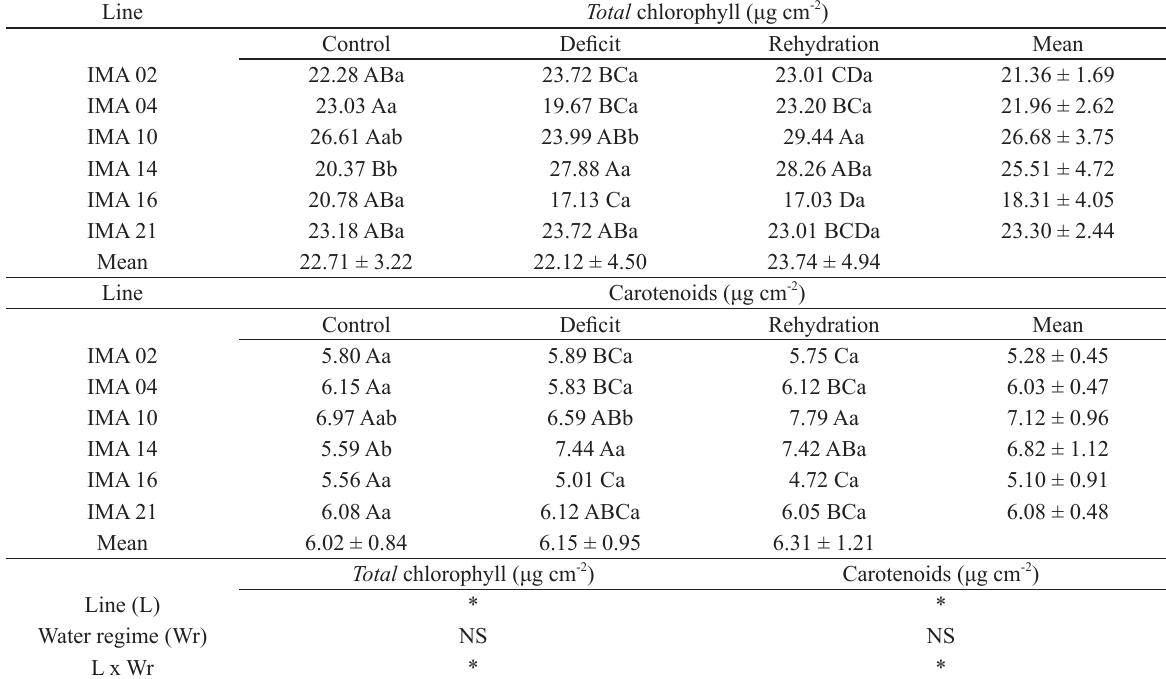
Effect of water deficit and rehydration on the content of total chlorophyll and carotenoids in six safflower lines in Botucatu – São Paulo,